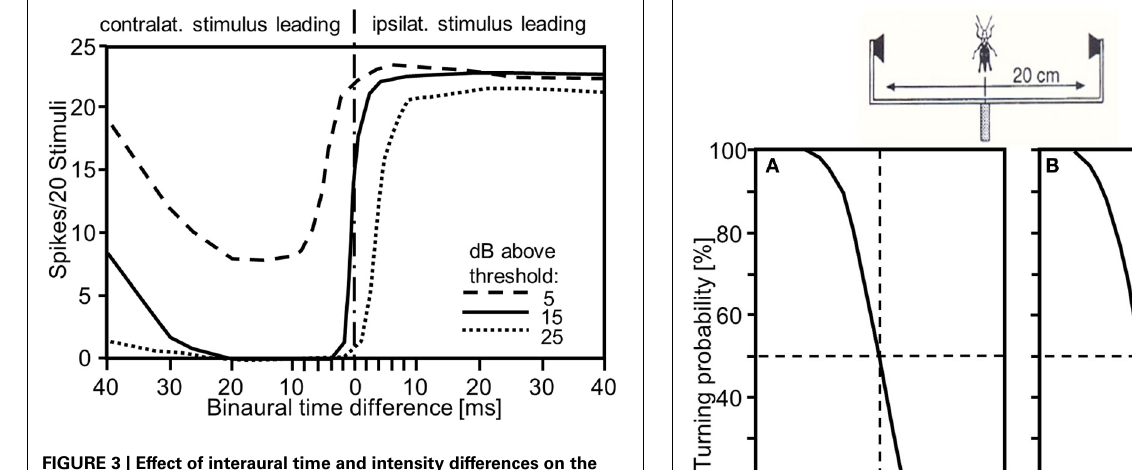
FIGURE 3 | Effect of interaural time and intensity differences on the response of an auditory interneuron in the locust. Note that the steepest slopes of the curves are produced by small interaural time differences in the order of 1–2ms, such as those provided by auditory receptors (compare with Figure 1B ), and that the slopes can be traded by changing interaural intensity differences (modified from Rheinlaender and Mörchen, 1979).